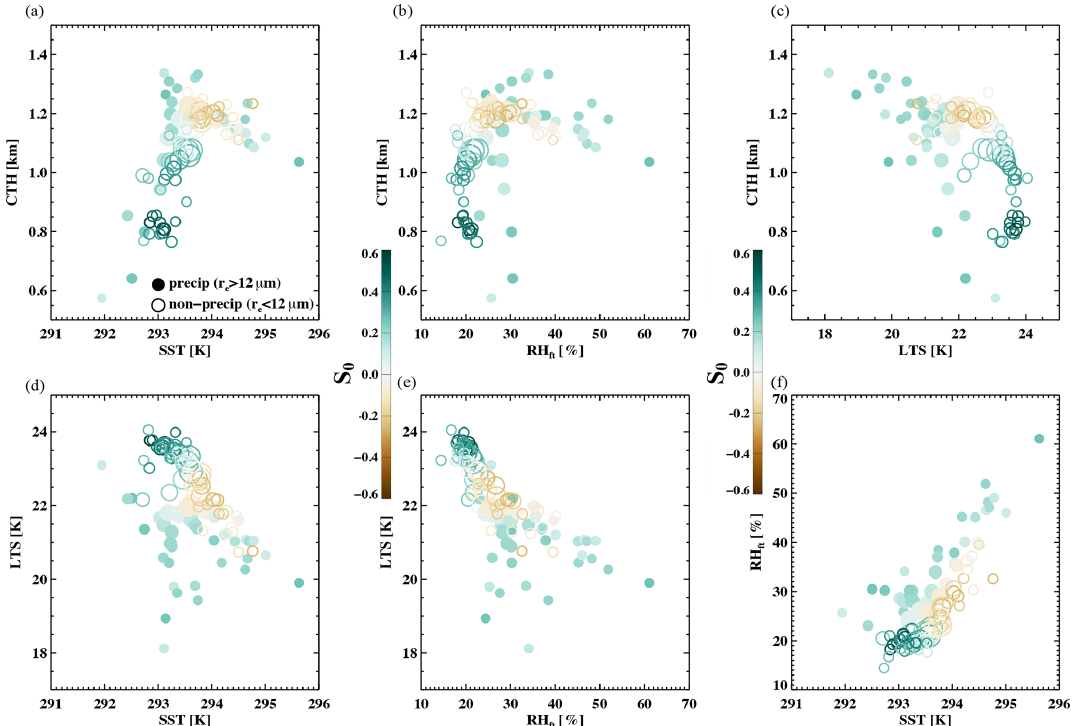
Figure 4. Mean meteorological/cloud state conditions associated with each LWP– N d bin in Fig. 3, in the space of (a) CTH–SST, (b) CTH– RH ft , (c) CTH–LTS, (d) LTS–SST, (e) LTS–RH ft , and (f) RH ft –SST. Size and color of the circles represent the frequency of occurrence and the mean S 0 of that LWP– N d bin, respectively, as shown in Fig. 3. Precipitating clouds (based on a r e threshold of 12µm) and non- precipitating clouds are indicated by filled and open circles,